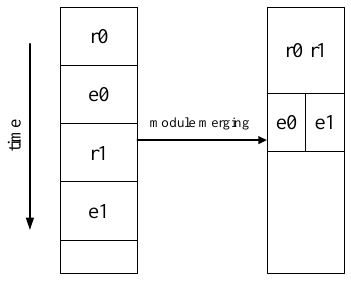
Figure 3. Module merge